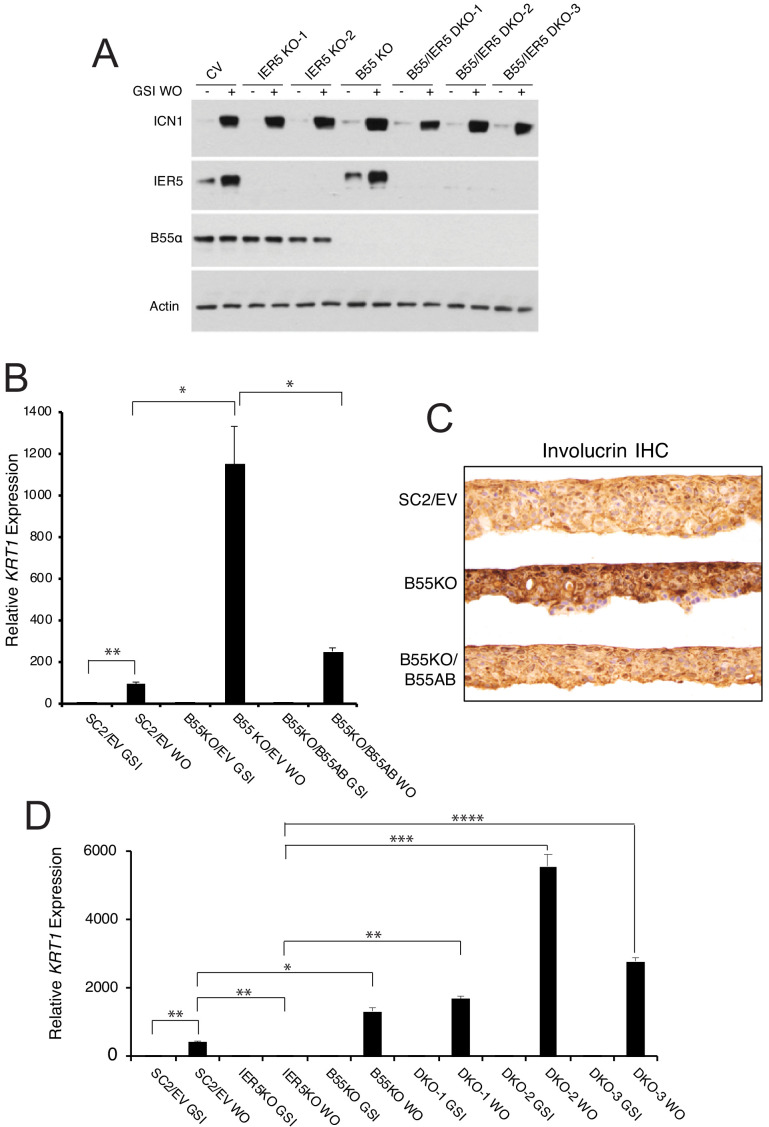
PPP2R2A is epistatic to IER5.(A) Western blot showing IER5 and B55α protein levels in single (KO) and double (DKO) PPP2R2A and IER5 knockout clones in the presence of GSI (-) and 4 hr after GSI washout (+). (B) PPP2R2A knockout enhances Notch-dependent expression of KRT1. RT-PCR analysis of KRT1 expression in SC2 cells transduced with an empty retrovirus (SC2/EV); PPP2R2A knockout cells (B55 KO) transduced with empty retrovirus (B55KO/EV); and PPP2R2A knockout cells transduced with B55α-expressing retrovirus (B55KO/B55AB). WO = GSI washout. *, p<0.05; **, p<0.005 (two-tailed student t test). (C) Immunohistochemical (IHC) staining for involucrin of SC2 control, B55KO, and B55KO/B55AB cells in raft cultures in GSI-free medium. (D) B55α knockout negates the requirement for IER5 for Notch-dependent upregulation of KRT1. Results are shown for SC2 control cells (SC2/EV); an IER5 knockout clone; a PPP2R2A knockout clone (B55KO); and three IER5/PPP2R2A double knockout (DKO) clones. Cells were maintained in GSI or harvested 72 hr following GSI washout (WO). KRT1 transcript abundance was measured in biological replicates prepared in triplicate by RT-PCR and normalized against GAPDH. Error bars represent standard errors of the mean. *, p<0.05; **, p<0.005; ***, p<0.0005; ****, p<0.00005 (all two-tailed student t test).